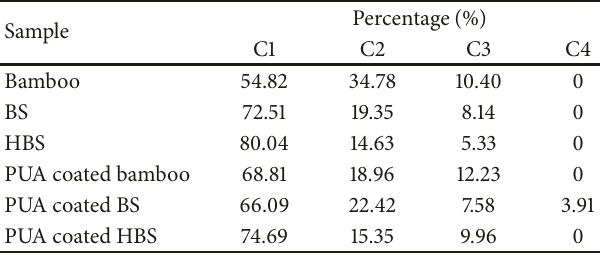
Table3:Elementspercentagesofbamboo,BS,HBS,andtheircoated